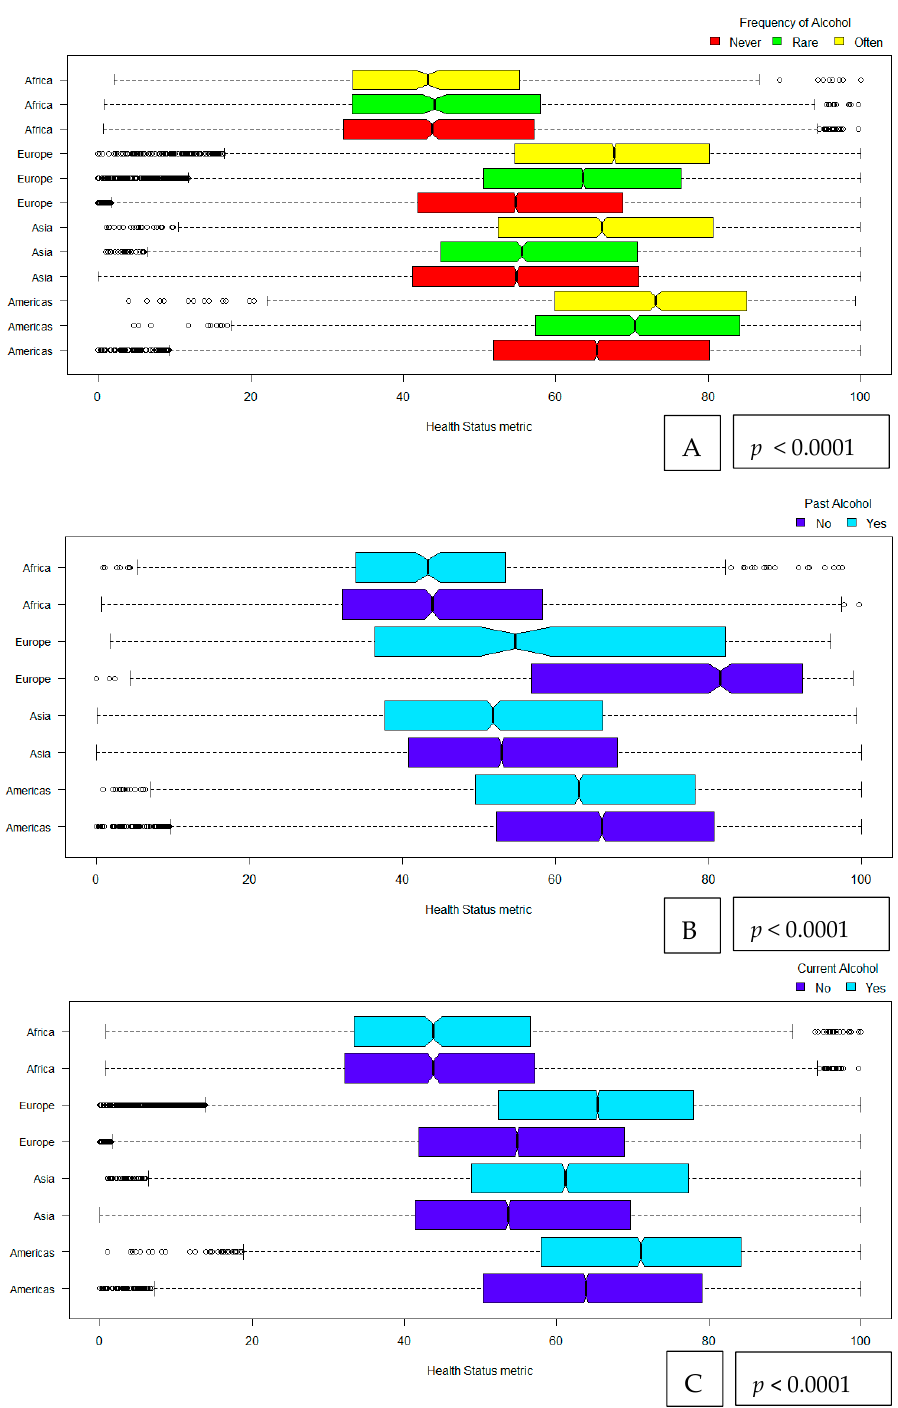
Figure 3. Alcohol drinking [frequency of drinking ( A ), past drinking ( B ) and current drinking ( C )] and its relationship with health status metric among older adults by super ‐ regions. Frequency of alcohol drinking is expressed as never, rare and often. Past and current alcohol drinking are following a binary categorization of yes vs no. Americas includes the regions of North and South America; Asia includes regions in Asia and Oceania as they are reflected within the ATHLOS data.